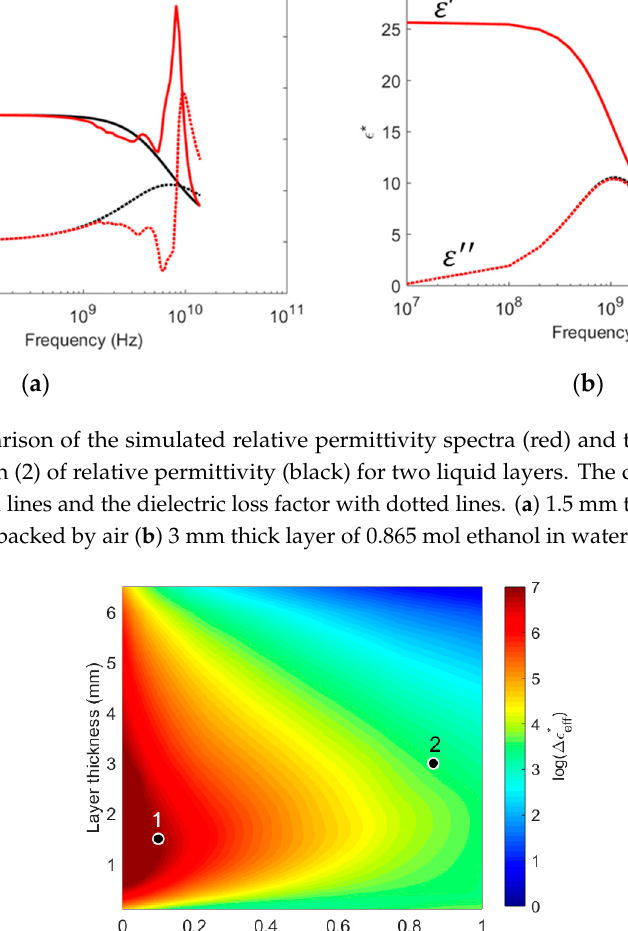
Figure 4. Comparison of measured and simulated relative permittivity spectra for liquid water layers. Liquid water reference spectrum is included. The dielectric constant is plotted with solid lines and the dielectric loss factor with dotted lines. ( a ) 3 mm water layer backed by air ( b ) 5 mm water layer backed by air.